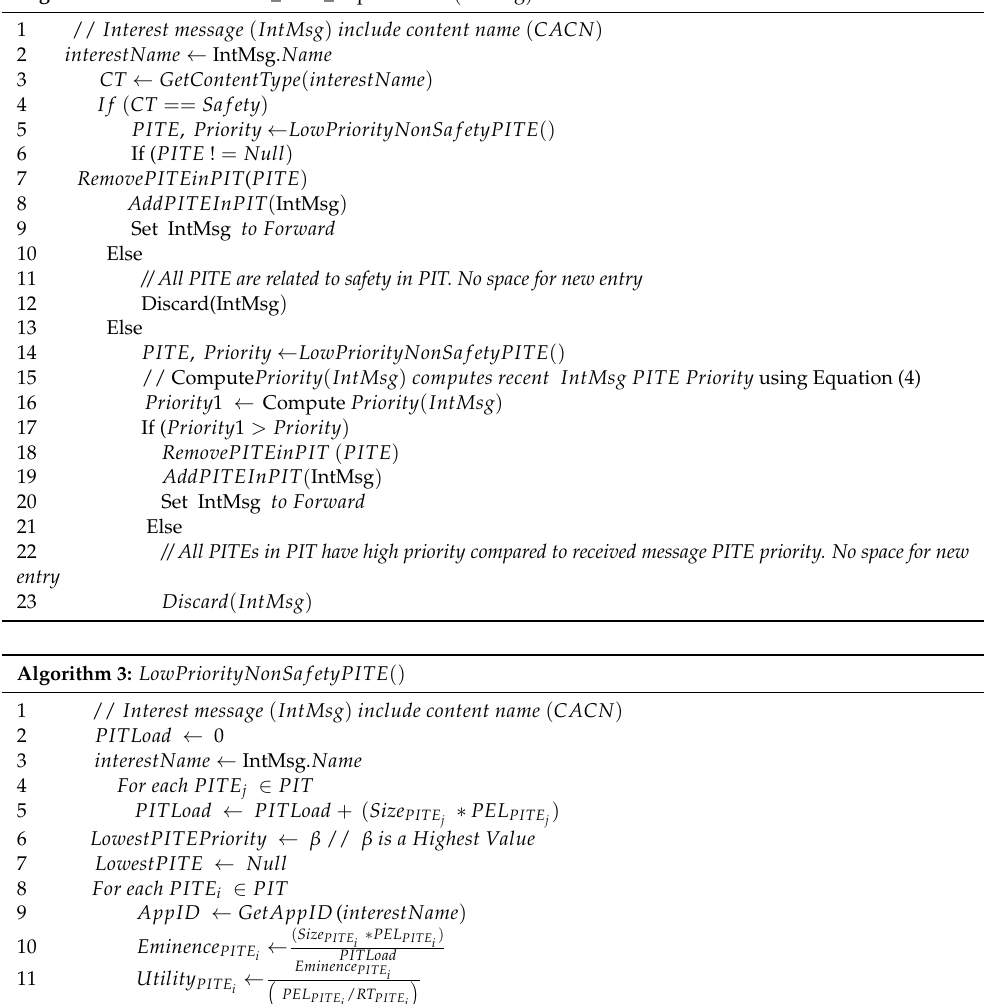
Algorithm 2 : Contextaware_PITE_Replacement ( IntMsg )